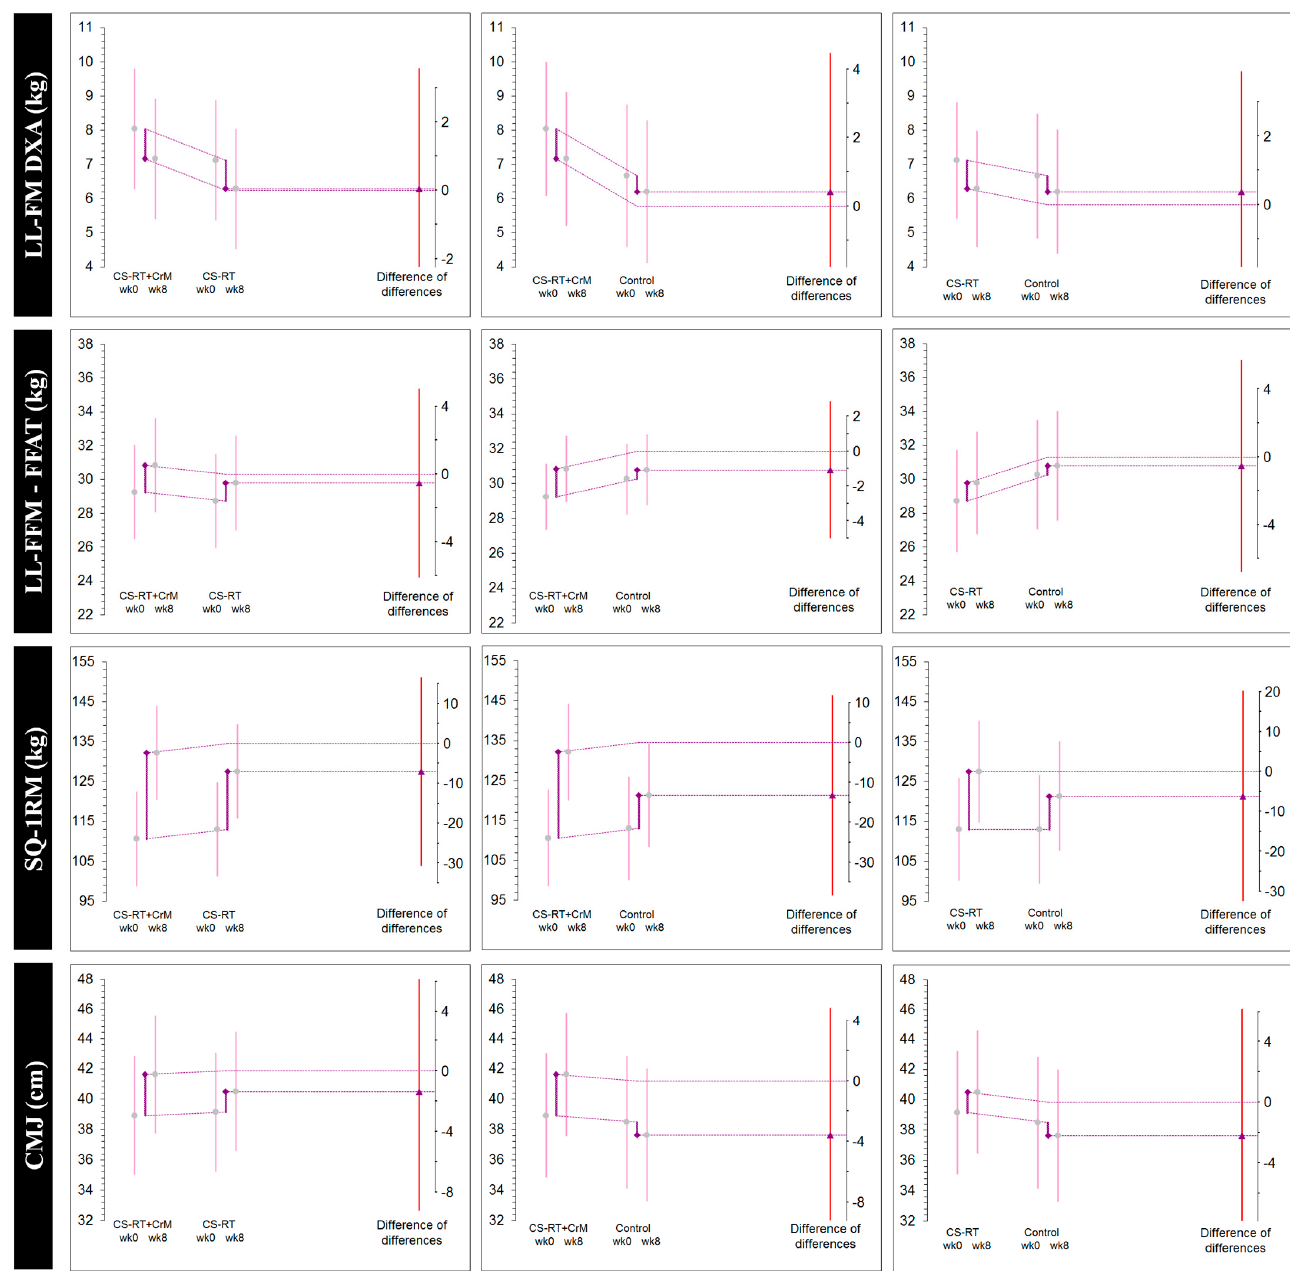
Figure 4. Difference-in-difference estimation plots for all variables. This graphic shows the difference ( Δ = Week 8–Week 0) of the differences, which is the calculation of the group means: CS-RT+CrM ( Δ 1 ), CS-RT ( Δ 2 ), and control ( Δ 3 ) groups on lower-limb body composition and strength-related variables. The effect chosen for examination is displayed as the triangle, with its 95% CI, against a floating different axis.